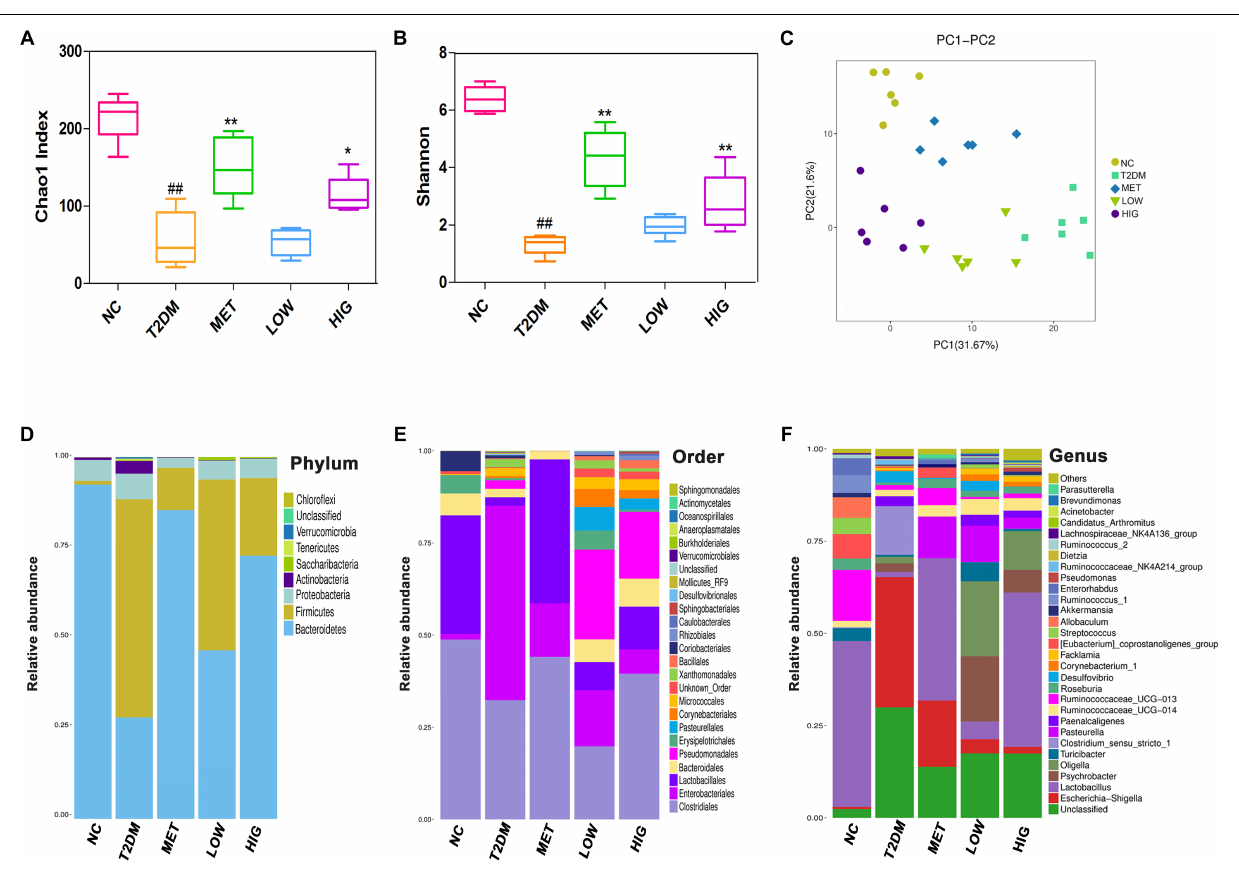
account for 98% of the total number (Wu et al., 2010).